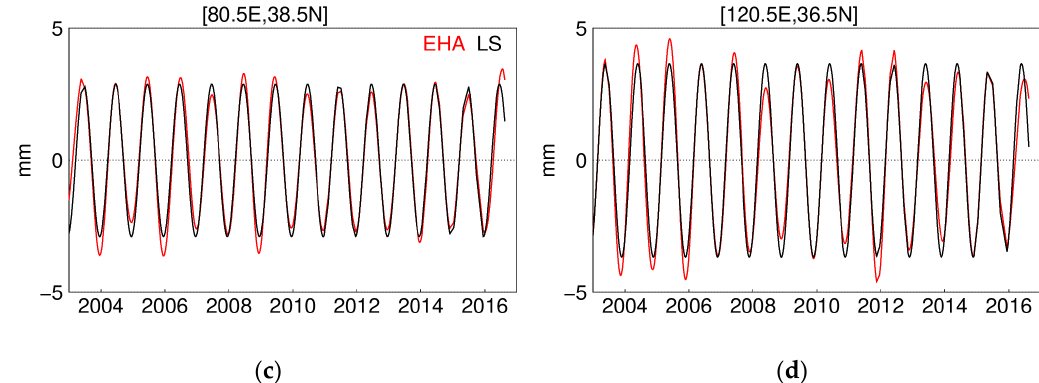
Figure 6. Annual signal extracted with enhanced harmonic analysis (EHA) and least square (LS) at selected grids: ( a ) at grid (120.5 E, 48.5 N); ( b ) at grid (102.5 E, 23.5 N); ( c ) at grid (80.5 E, 38.5 N); ( d ) at grid (120.5 E, 36.5 N).